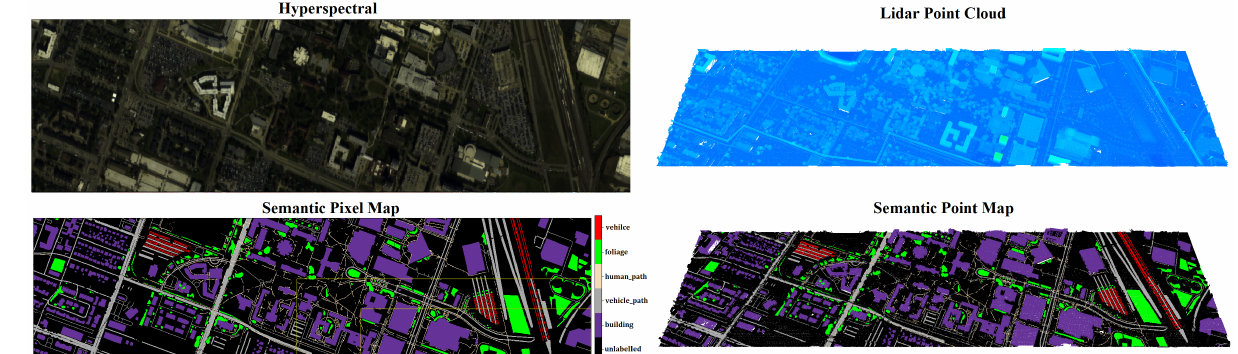
Figure 3. Altered GRSS18 data set utilized in this work. ( Top Left ) Complete hyperspectral image used in this work, originally a subset of GRSS18 hyperspectral image. ( Top Right ) Complete lidar point cloud used in this work, originally Channel 1 of the GRSS18 multispectral lidar. Coloring of points based on height above ground. ( Bottom Left ) Semantic pixel map of superclass values over the hyperspectral image. ( Bottom Right ) Labeled lidar point cloud used for training point convolution-based